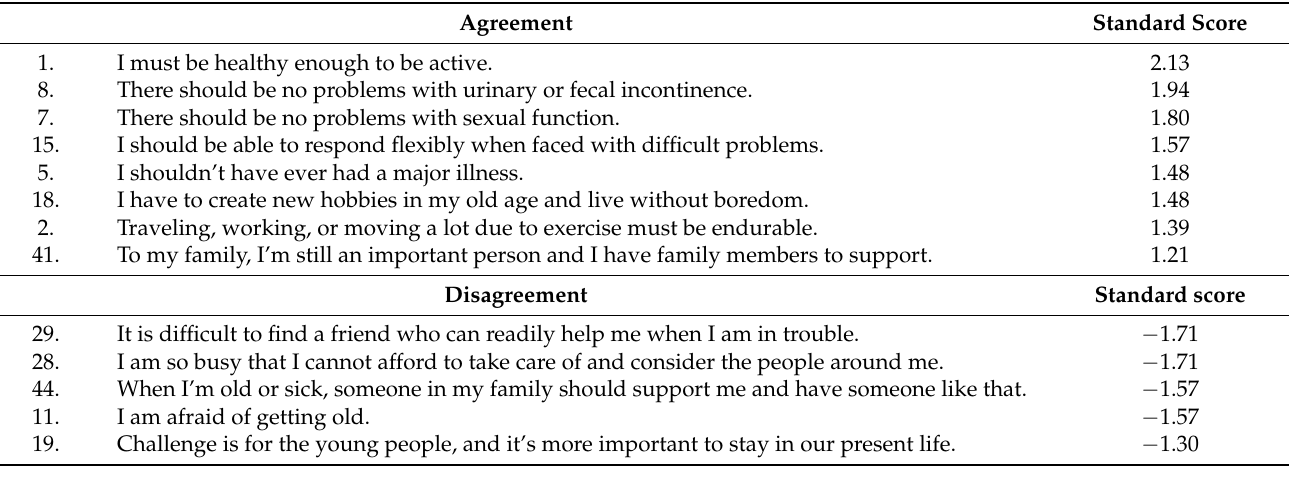
Table 7. The Q-statements with strong agreement or disagreement by Type 3.